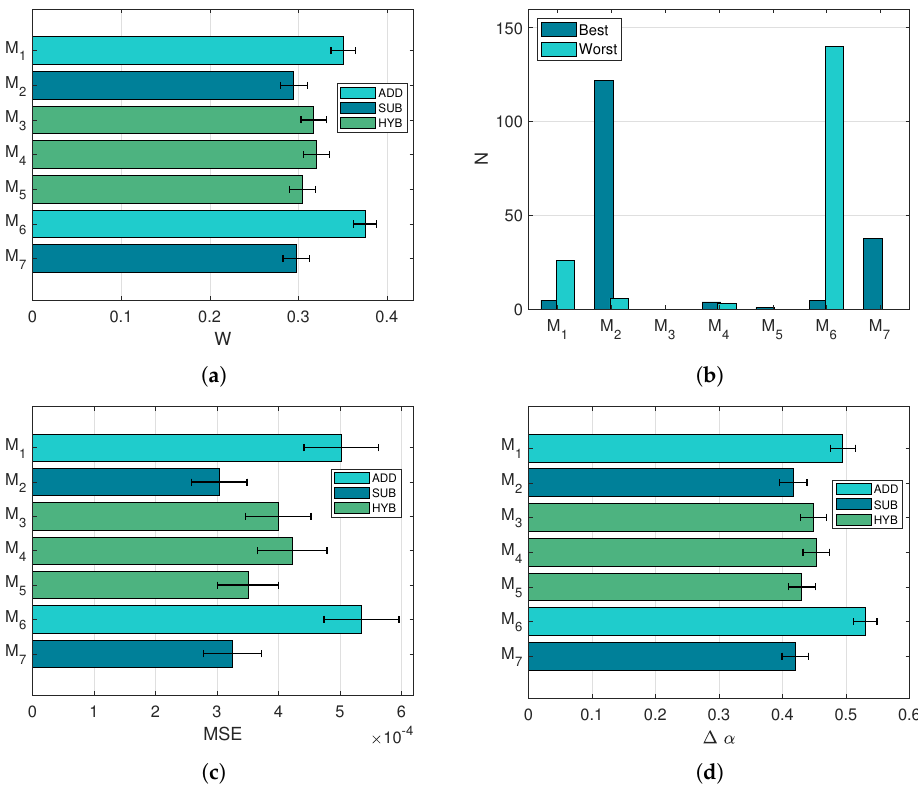
Figure 8. Performances in the spectral unmixing task. All error bars refer to 95% confidence intervals. ( a ): Mean w score. ( b ): Number of times each model has been selected as best or worst in terms of w score. ( c ): Average MSE. ( d ): Mean concentration error ∆ α .